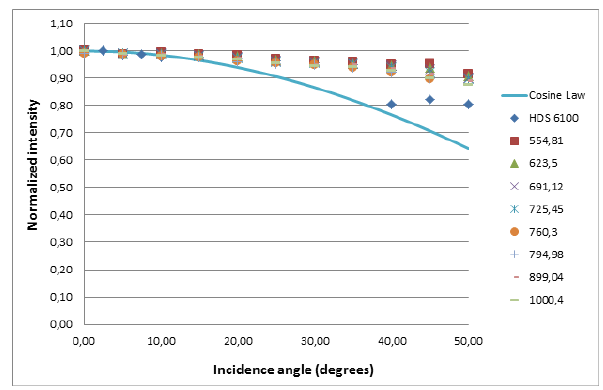
Figure 3. Kivenlahti beach sand (>500 µm grain size) scanned with hyperspectral Lidar, compared with the same sand sample scanned with the Leica HDS6100 from the experiment described in Section 2.3. The wavelength channels are denoted in the legend. Intensity is normalized to 1 at 0 ⁰